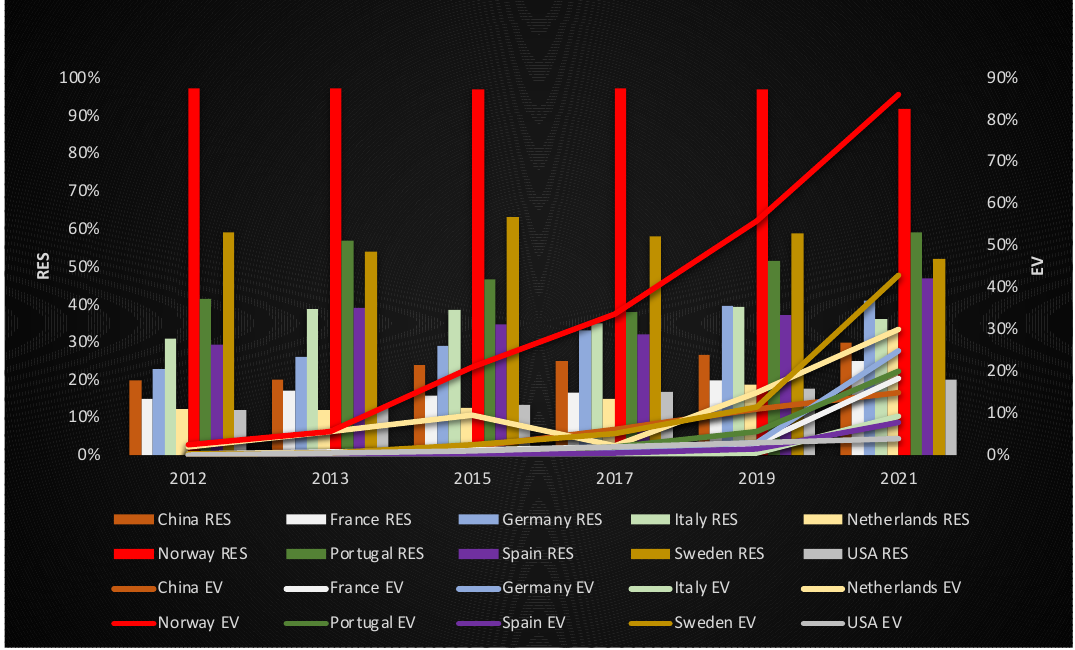
Figure 8. Top market share countries in renewable energy and EV. Source: Authors’ own elaboration using data from [66 – 72].